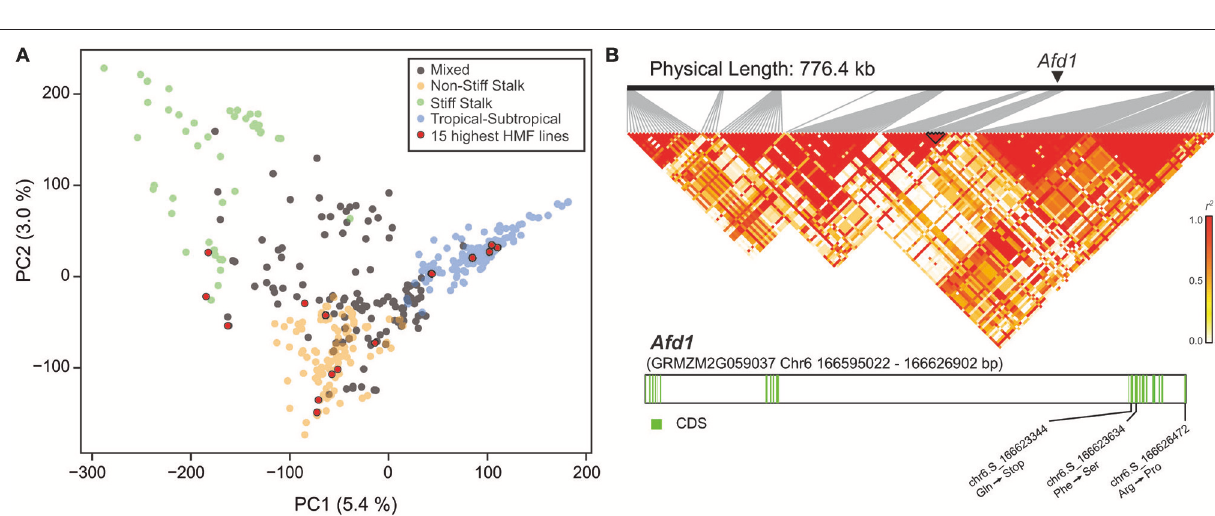
FIGURE 2 | (A) Principal coordinate plot illustrating the population structure and highlighting the 15 genotypes with the highest haploid male fertility (HMF). (B) Linkage disequilibrium in the qhmf4 genomic region, with the position of the Afd1 gene indicated. Structure of the Afd1 gene, with the positions of the three SNPs leading to amino acid